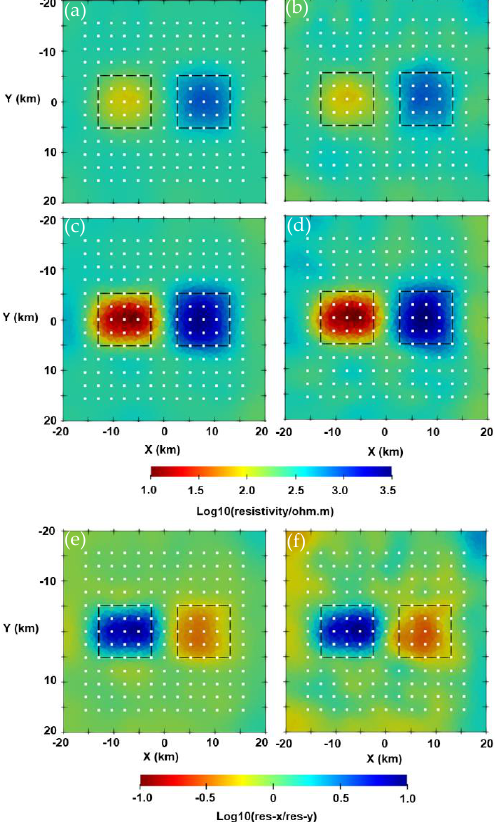
Figure A2. Anisotropic inversion results at z = 6 km. Panels ( a ) and ( b ) show the inverted resistivity in the principal X direction for 𝐖 𝑑 with nonuniform and uniform data variance. Panels ( c ) and ( d ) show the inverted resistivity in the principal Y direction for 𝐖 𝑑 with nonuniform and uniform data variance. Panels ( e ) and ( f ) show the inverted anisotropic coefficient for 𝐖 𝑑 with nonuniform and uniform data variance.